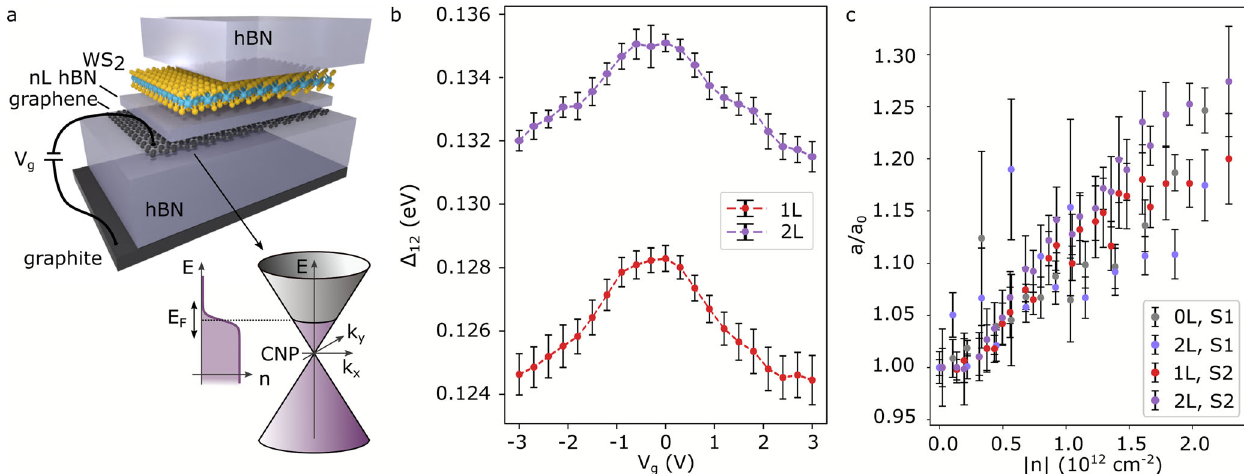
Fig. 3 Dependence of the screening on charge carrier density in graphene. a Sketch of the device geometry (top) used to tune the charge carrier density of graphene from electron ( n > 0) to hole ( n < 0) doping (bottom). b 1s-2s exciton energy difference vs. backgate voltage V G for different hBN spacer layers. c Relative change of the parameter a (see Eq. (1)), proportional to the magnitude of the image charge in graphene, as a function of the absolute charge carrier density ∣ n ∣ of graphene. S1 and S2 denote different samples. Error bars are standard deviations from analyzing several spatial